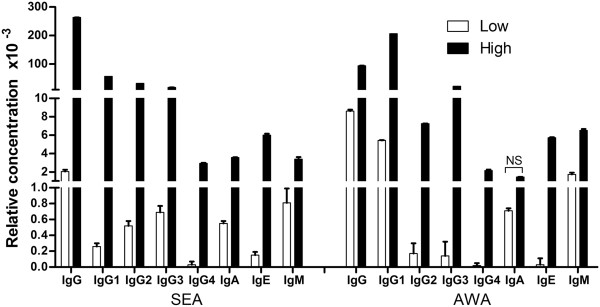
Schistosome-specific antibody isotype levels in low and high antibody responders. Serum levels of schistosome-specific IgG, IgG1, IgG2, IgG3, IgG4, IgE, IgM, IgA were analysed by ELISA. Relative concentrations of antibody isotypes were compared between the high responders and low responders. NS, no significance. Open square bars represent mean of relative antibody concentration of low responders, black square bars represent mean of relative antibody concentration of high responders. Error bars represent SEMs.